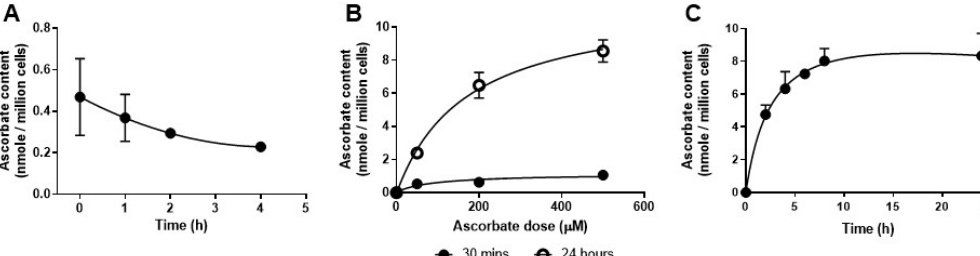
Figure 2. Ascorbate retention and uptake in LLCM-grown bone marrow derived macrophages. ( A ) Ascorbate levels were measured in freshly isolated mononuclear cells from bone marrow. Levels were detected upon isolation but reduced over subsequent hours. ( B ) Ascorbate uptake experiments were performed on LLCM-grown bone marrow derived macrophages at day 7. Dose response ascorbate uptake was measured at 30 min and 24 h post treatment. Minimal uptake was detected at